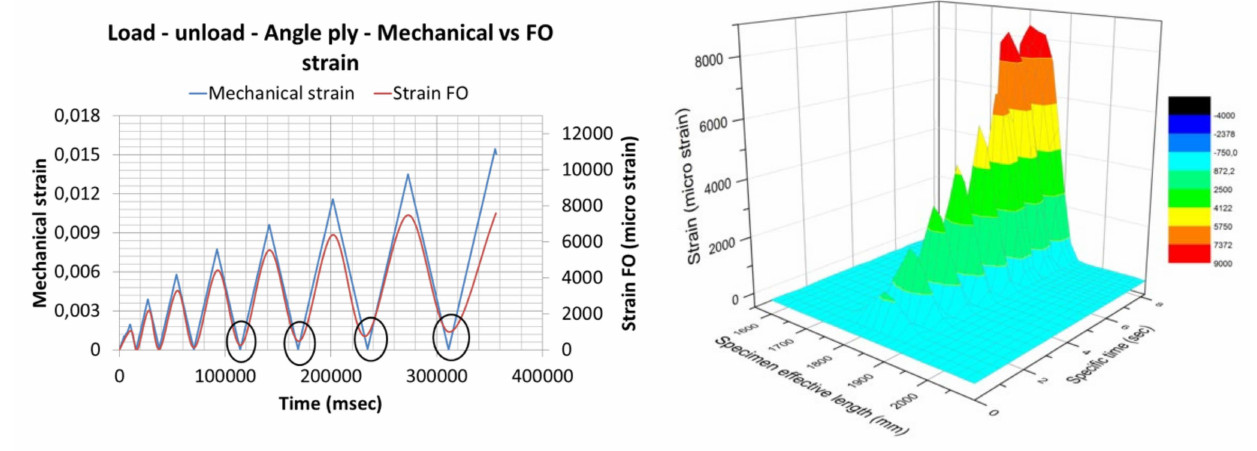
Figure 15. Load–unload test curve and 3D curve for smart angle-ply